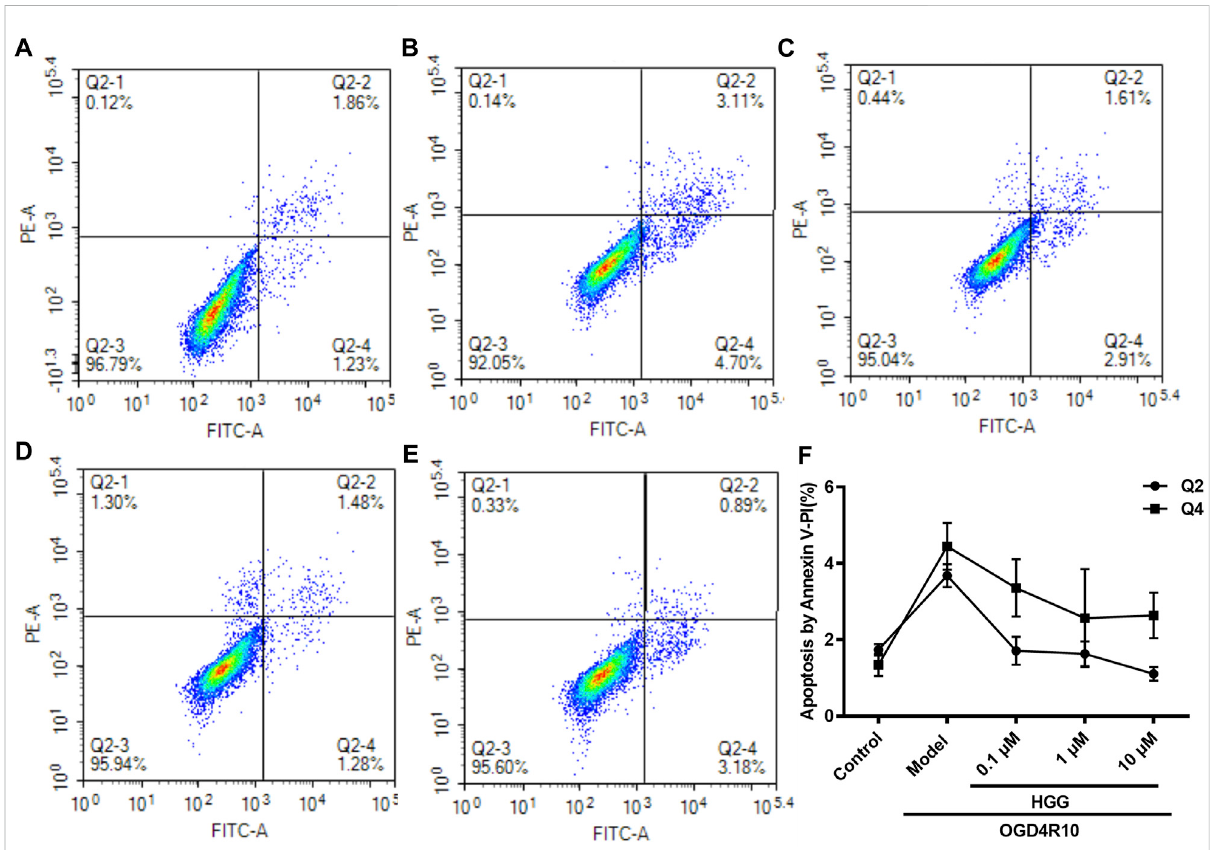
FIGURE 4 OGD/R-induced apoptosis in HUVECs using Annexin V-FITC/PI staining. (A) Control; (B) OGD/R; (C) 0.1 μ M HGG + OGD/R; (D) 1 μ M HGG + OGD/R; (E) 10 μ M HGG + OGD/R. Quadrant distinction: upper left corner quadrant for dead cells, lower left corner quadrant for living cells, upper right corner quadrant for advanced apoptotic cells, and lower right corner quadrant for the early apoptotic cells. (F) The apoptosis rate of HUVECs after exposure to OGD/R.